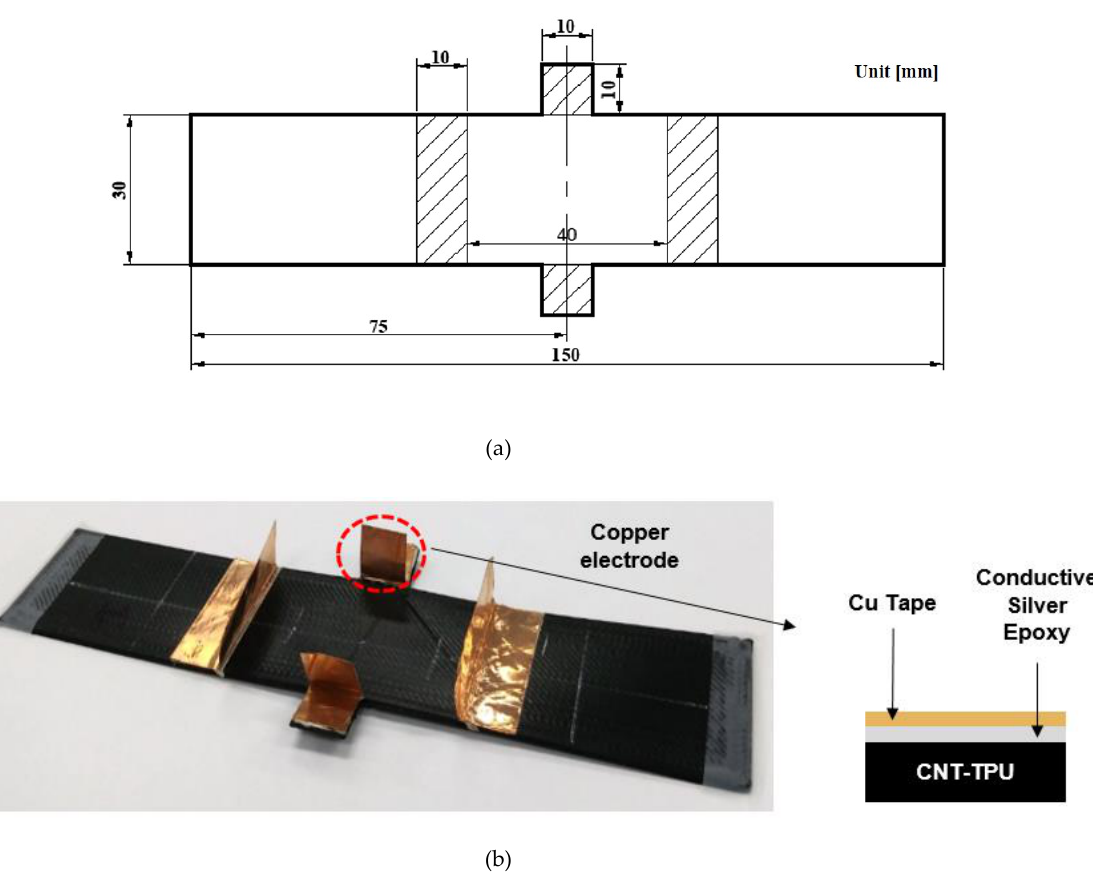
Figure 4. ( a ) Dimensions and ( b ) copper electrodes of the specimens for tensile tests.